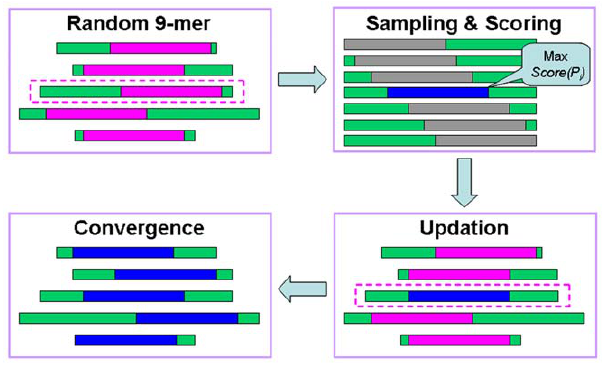
Figure 1. A schematic diagram for the adapted Gibbs sampling approach which was used to determine the nonamer core peptides for I-A g7 and HLA-DQ8 epitopes.